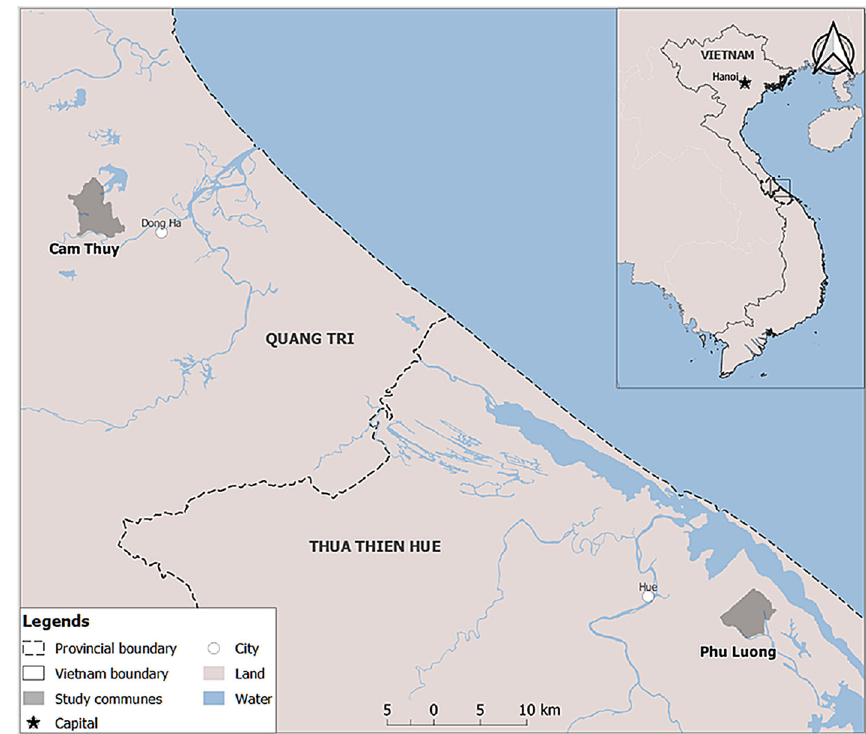
Fig. 1 Locations of the two study communes in Vietnam— Cam Thuy Commune, Quang Tri Province, and Phu Luong Commune, Thua Thien Hue